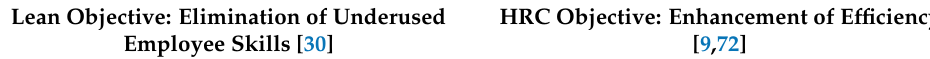
Table 5. Comparison of scope between lean’s goal of elimination of underused skills and HRC’s goal of improved